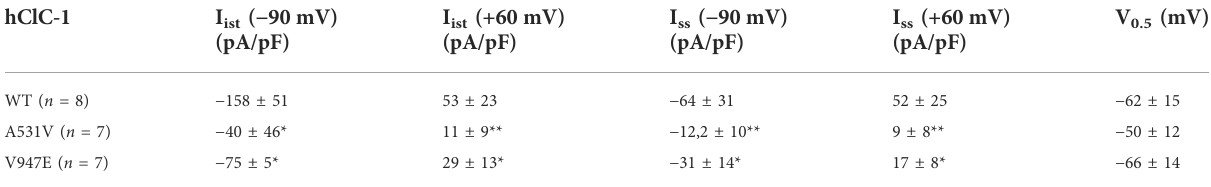
TABLE 1 Biophysical parameters of hClC-1 WT and MC mutants.